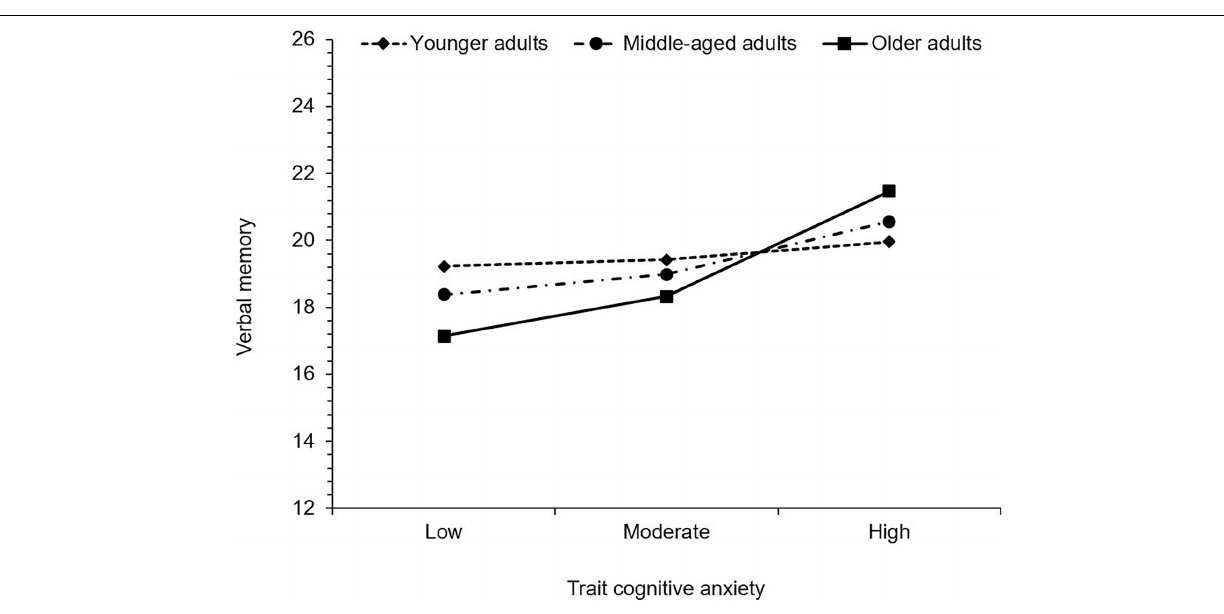
FIGURE 2 | Simple slopes illustrating the significant interactions between trait cognitive anxiety and age on verbal memory. Higher values indicate greater levels of subjective cognitive